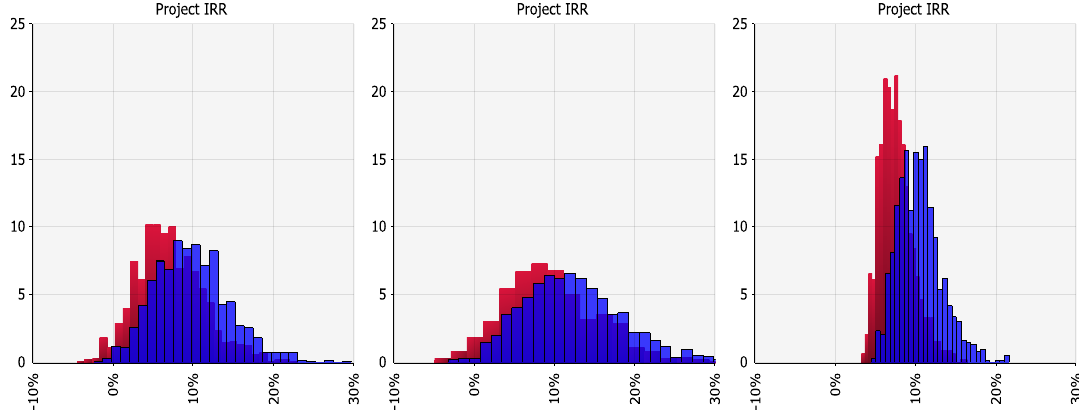
Figure 5. Project IRR distributions of Coal, Wind, and Nuclear with 0% and 3% TGR.